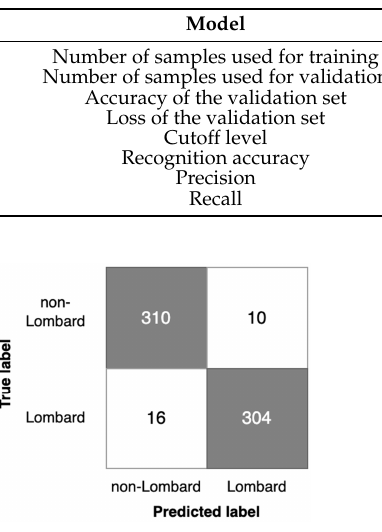
Figure 9. Confusion matrix for the G2 model.